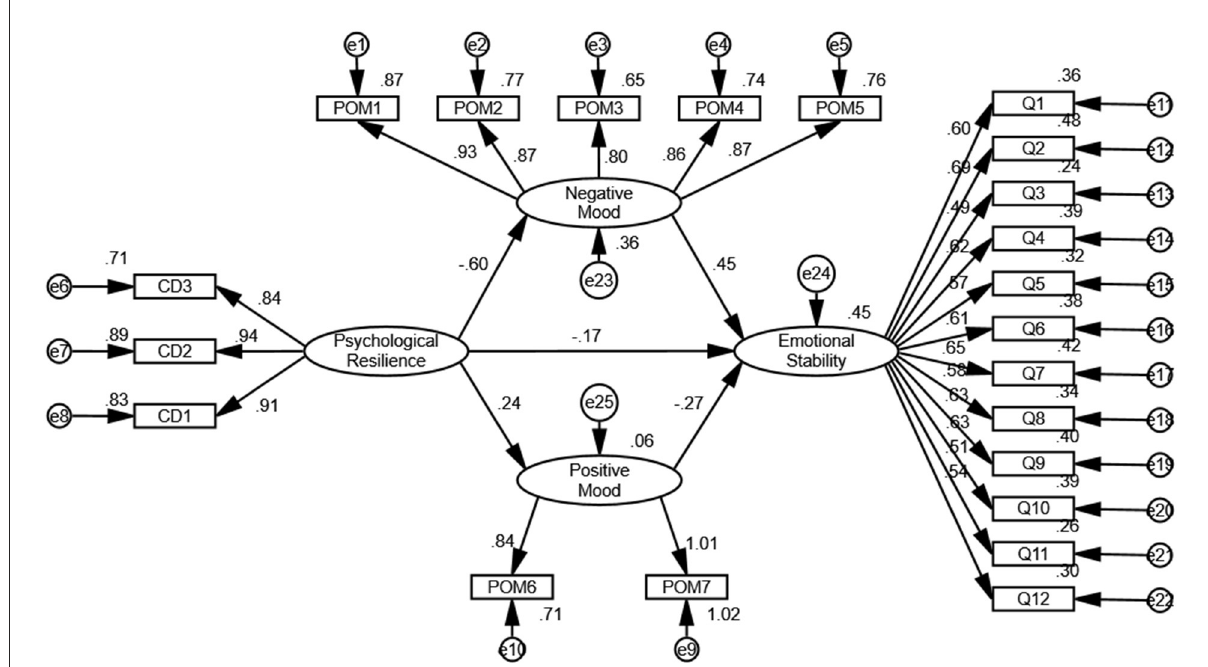
FIGURE2 Indirect prediction of mood state on emotional stability of high school students and parallel mediation model examination of negative mood state and positive mood state. Values next to arrows indicate standardized path coefficients. POM1–7 represents nervousness, anger, fatigue, depression, panic, energy and self-esteem; CD1–3, tenacity, strength and optimism; e1–25, residuals; Q1–12, questions 1 through 12 on the scale.